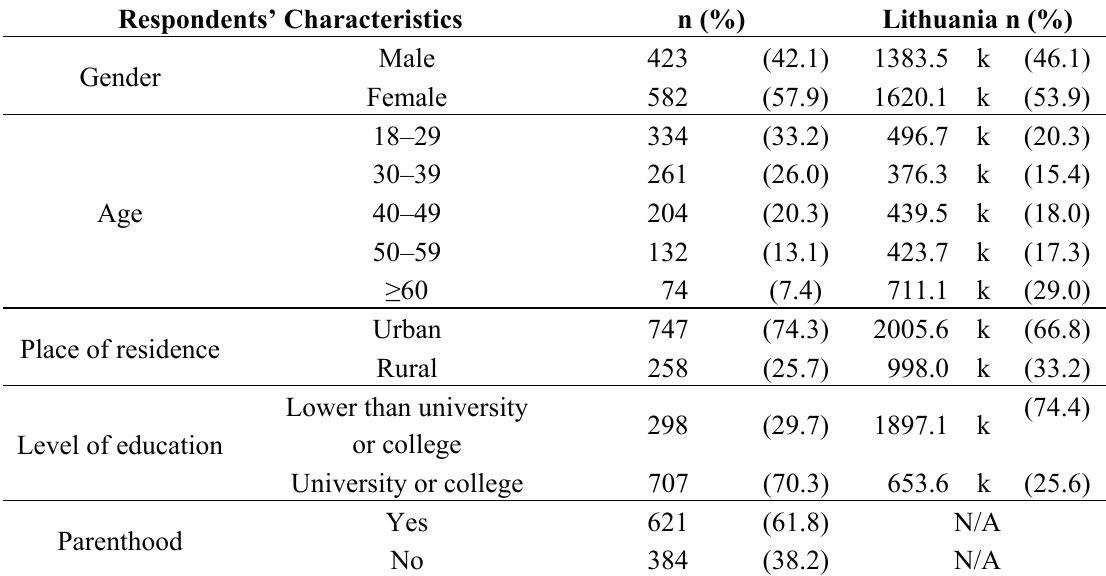
Table 1. Demographic characteristics of respondents compared with the Lithuanian general population.